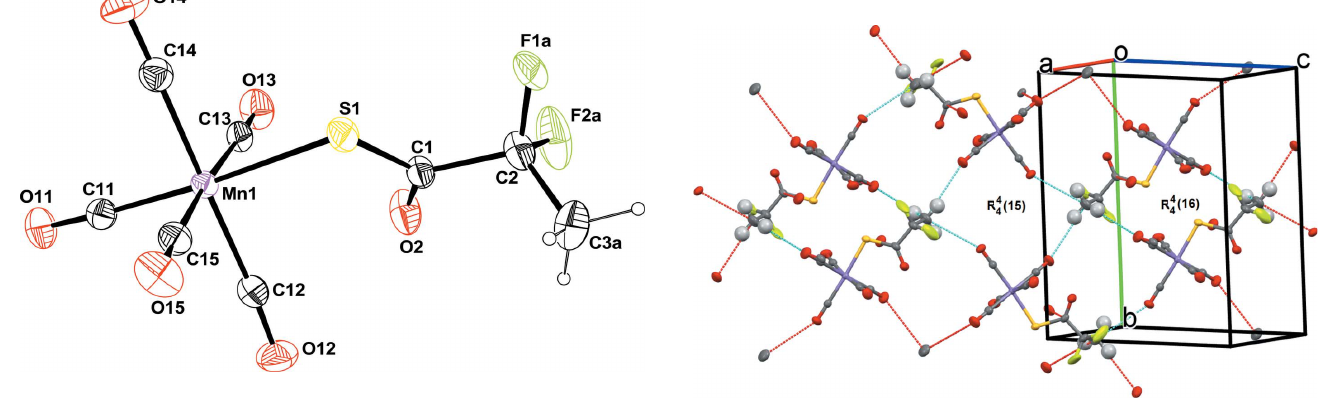
Figure 1 A view of the molecular structure of compound (1), with the atom labelling. For clarity, only the major disordered component of the –CF 2 group is shown. Displacement ellipsoids are drawn at the 50% probability